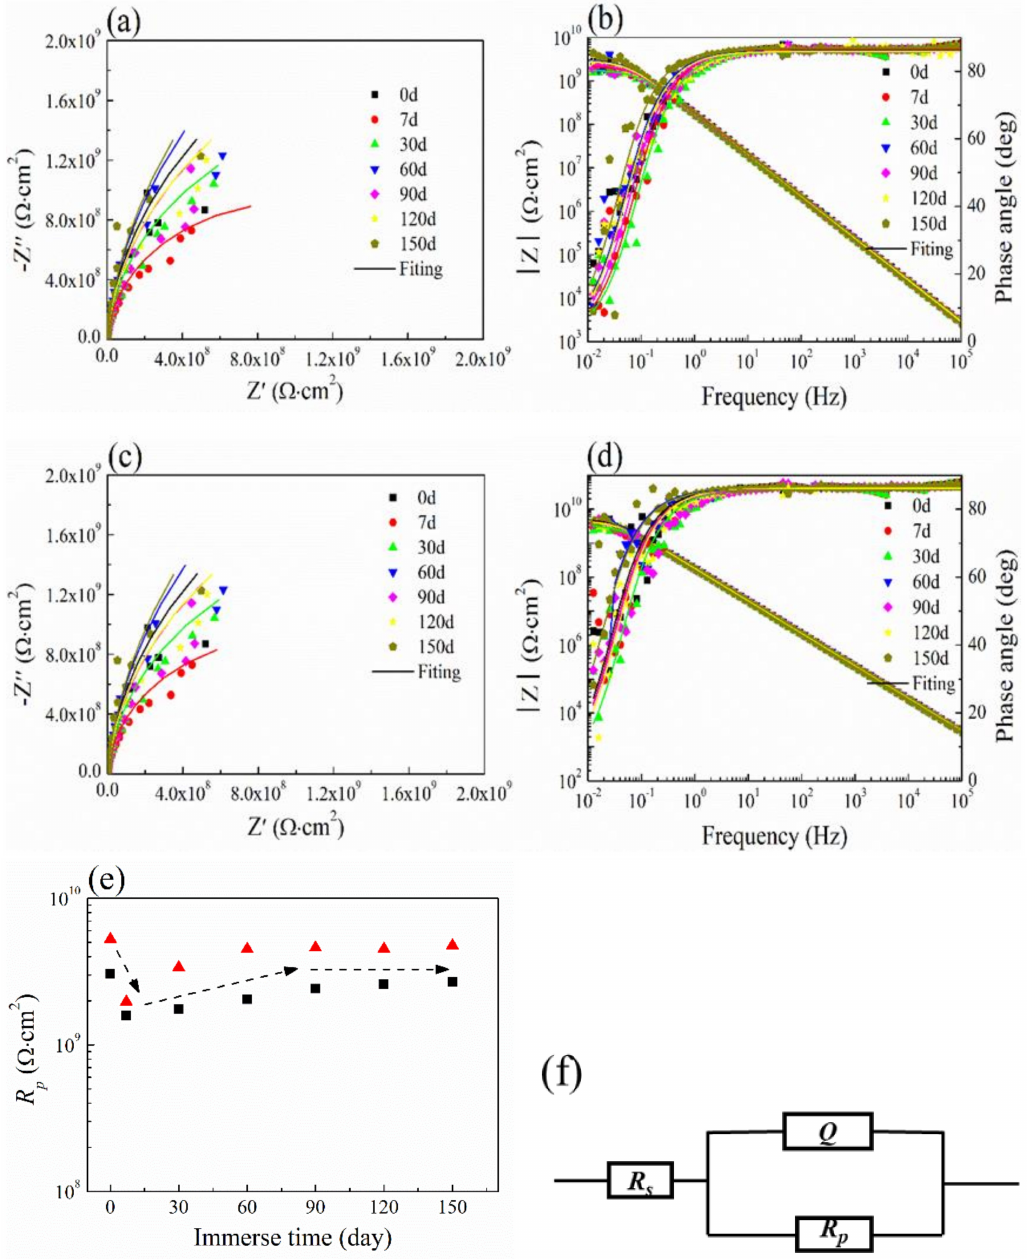
Figure 10. The EIS measurements during 150 days immersion in 3.5 wt.% NaCl solution, ( a ) the Nyquist plot of C-EC gel coating, ( b ) the Bode plot of C-EC gel coating, ( c ) the Nyquist plot of C-EC / TPU gel coating, ( d ) the Bode plot of C-EC / TPU gel coating, ( e ) the coating resistance change, and ( f ) the equivalent electrical